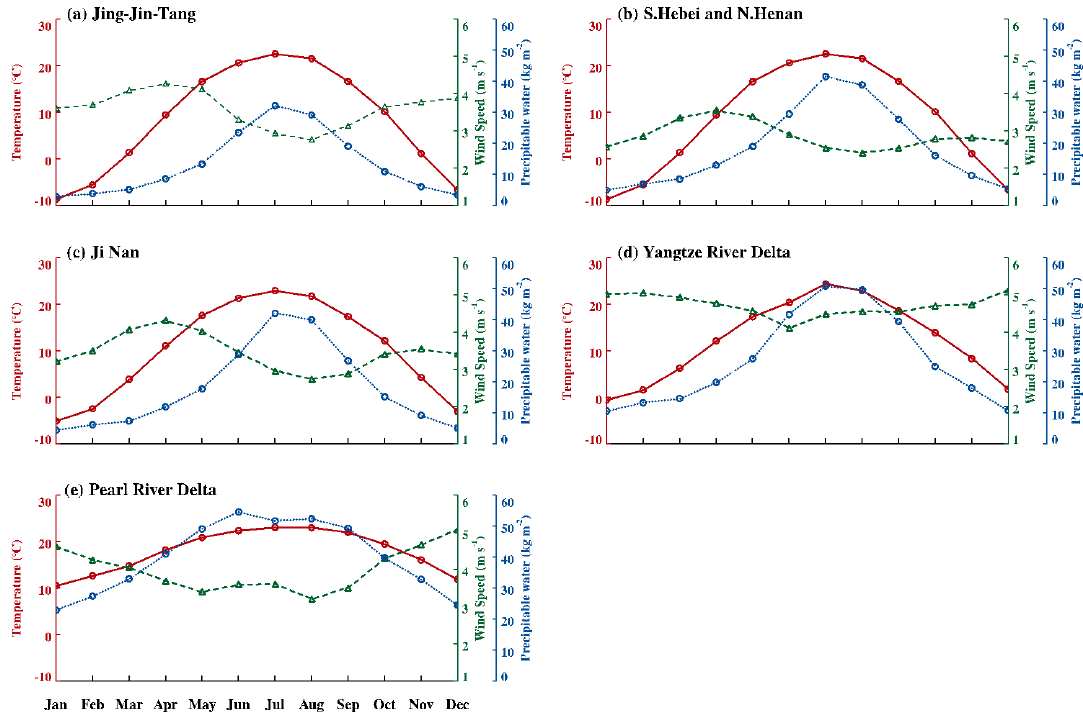
Figure 10. Annual cycle of precipitable water (unit: kg m − 2 ), wind speed (unit: m s − 1 ) and temperature (unit: ◦ C) at 975 hPa in five areas.